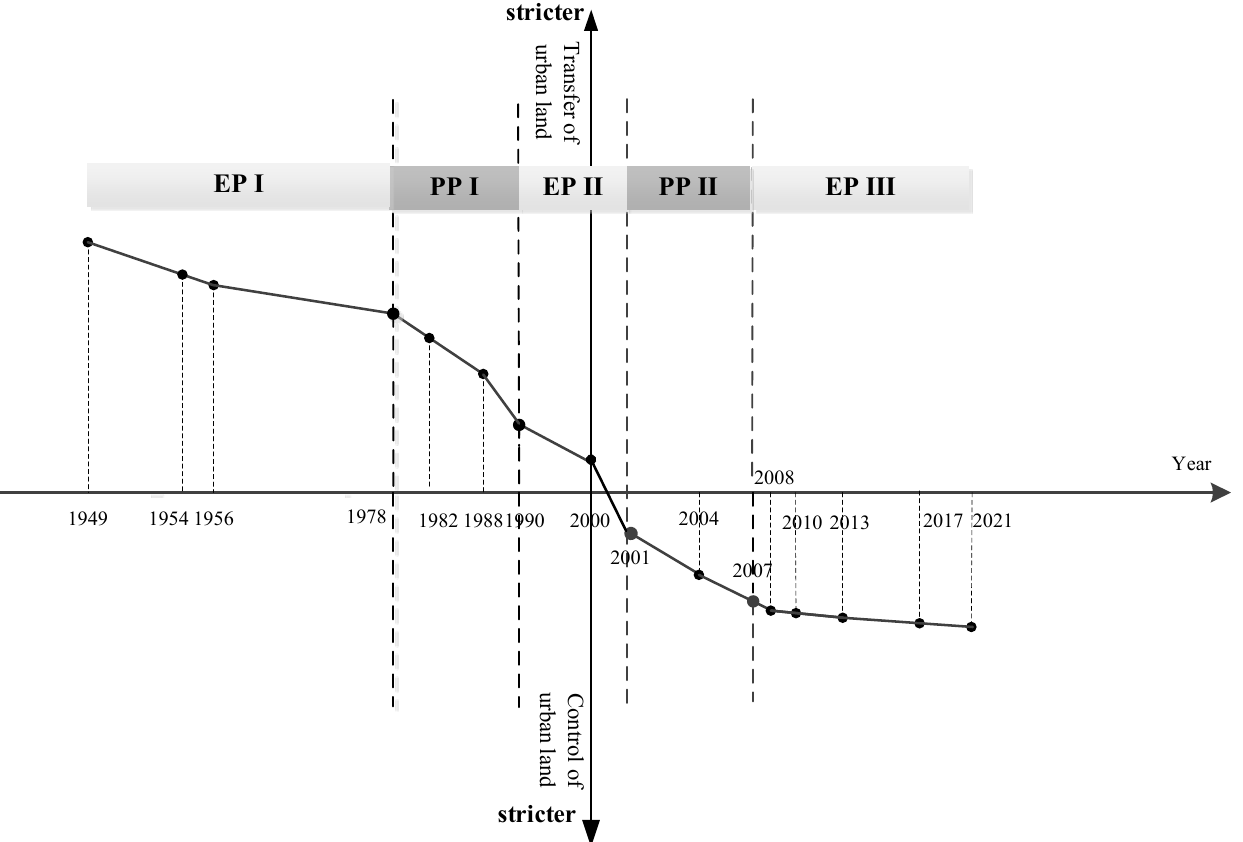
Figure 2. The process of urban land system reform in China (1949–2021). Note: (1) Source—The figure was drawn by the authors according to the division of equilibrium and punctuated periods in the above analysis. (2) EP represents an equilibrium period; PP represents a punctuated period. (3) The meaning of the horizontal axis is the year. There are typical land policies which were introduced in the year marked on the horizontal axis. (4) The upper half of the vertical axis reflects the intensity of the restriction on the transfer of urban land. The larger the vertical coordinate of the turning-point on the polyline, the stricter the land policies of the corresponding year regarding the transfer of urban land. (5) The lower half of the vertical axis represents the intensity of local governments’ control of urban land. The greater the distance between the turning-point and the horizontal axis, the stricter the control of urban land by local governments in the corresponding year. (6) The intersection of the horizontal and vertical axis is not the mathematical origin where the horizontal and vertical coordinates are both zero, but the year 2000. The intersection of the line with the vertical axis is located above the horizontal axis, which means that the transfer of urban land was less restricted in 2000, but not completely free. (7) The intersection of the line with the vertical axis does not represent any year, and is not mathematically significant.